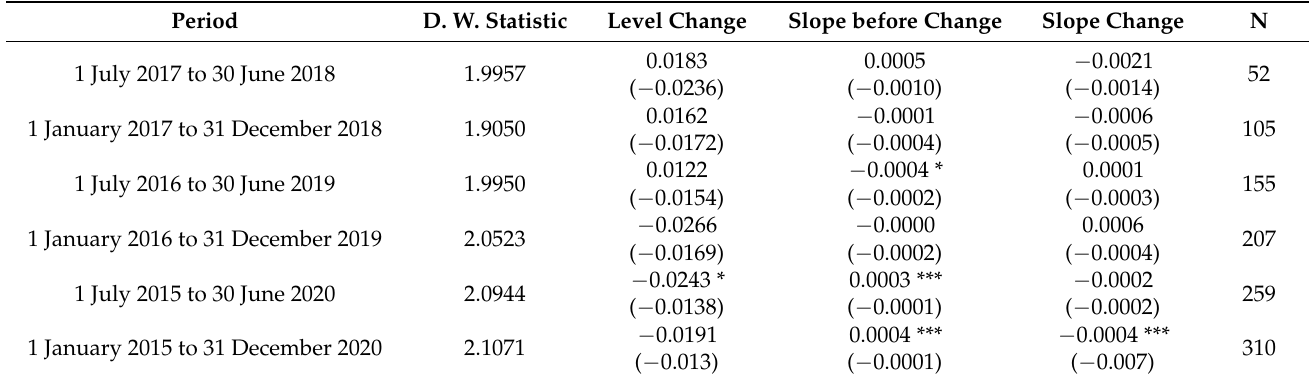
Table 2. Interrupted time series analysis.